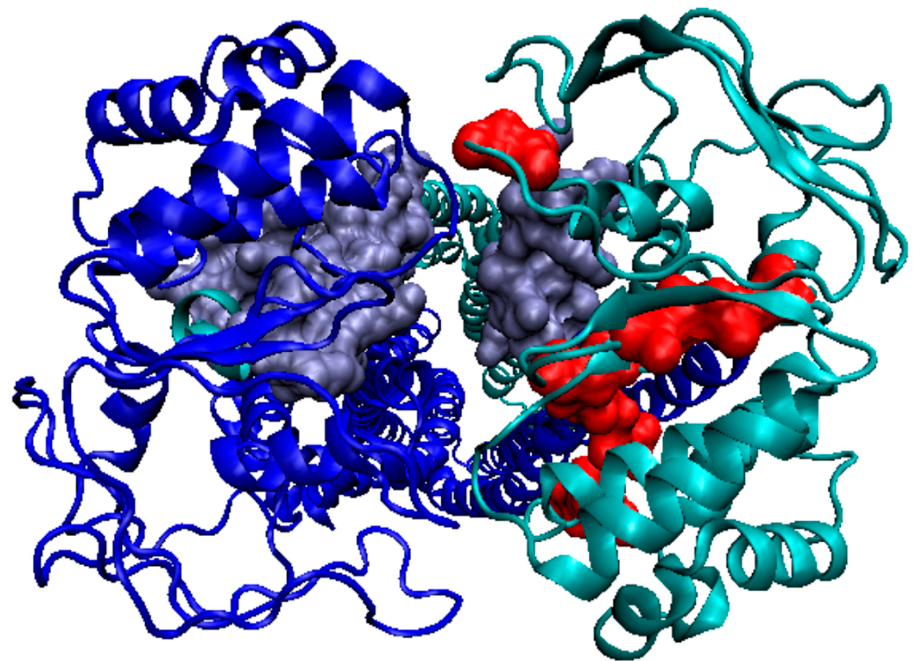
Figure 8. 3D structure of a homodimer (6UZL). In chain A (turquoise), sections showing local minima in places expected to be local maxima were distinguished. Chain A: turquoise, ice blue: sections within DD1 domains, red: sections within DD2 domains.